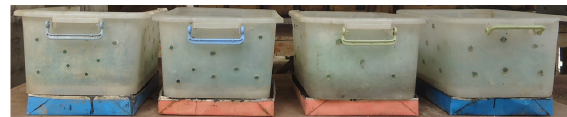
Fig. 3. Plastic boxes used for production of maggots